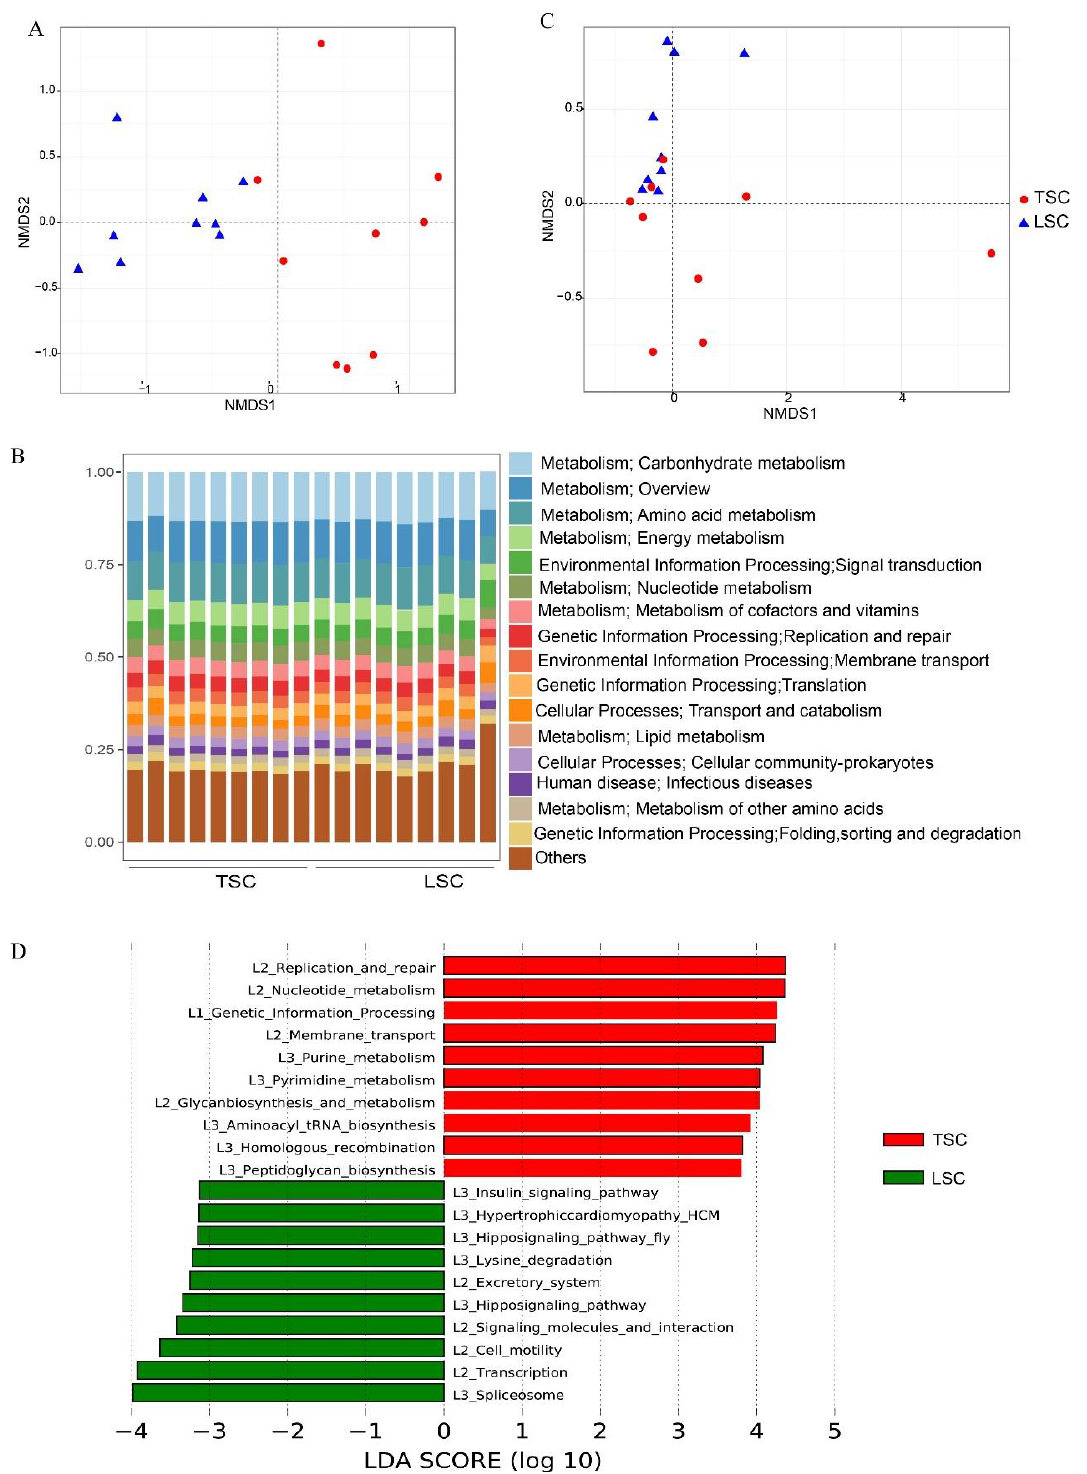
Figure 1. Composition and variation of microbial taxa and functional genes in dust of TSC and LSC aircraft. ( A ) NMDS ordination plot of aircraft microbial taxonomic composition, based on the Bray-Curtis distance matrix. ( B ) Abundance of functional pathways at second-level classification, according to the KEGG database. ( C ) NMDS ordination plot of aircraft functional gene composition, based on the Bray-Curtis distance matrix. ( D ) Characteristic pathways enriched in TSC and LSC aircraft, as determined with LEfSe analysis (LDA > 3 and p -value < 0.01). A total of 762,865 microbial genes were annotated using the KEGG database. The metabolism pathway accounted for 60.0% of annotated functional genes, followed by